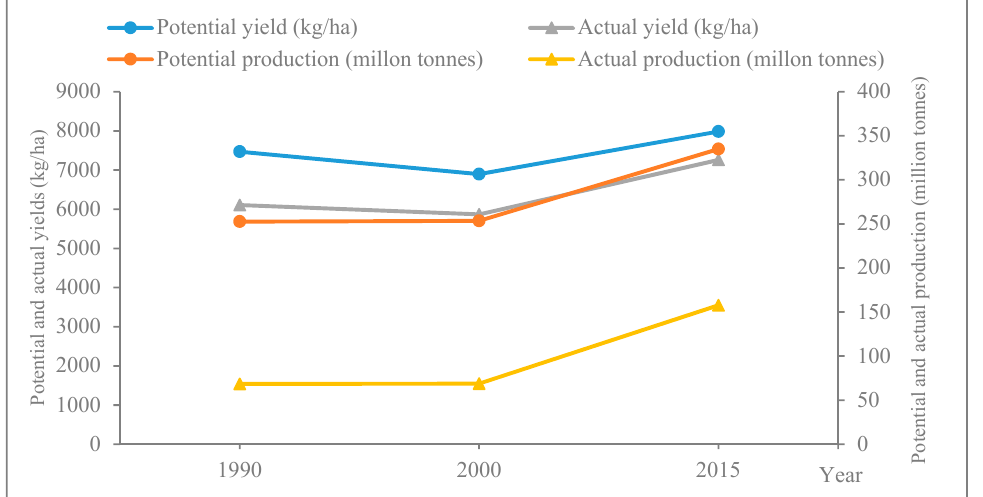
Figure 4. Changes of maize potential and actual yields and production in Northeast China from 1990 to 2015.